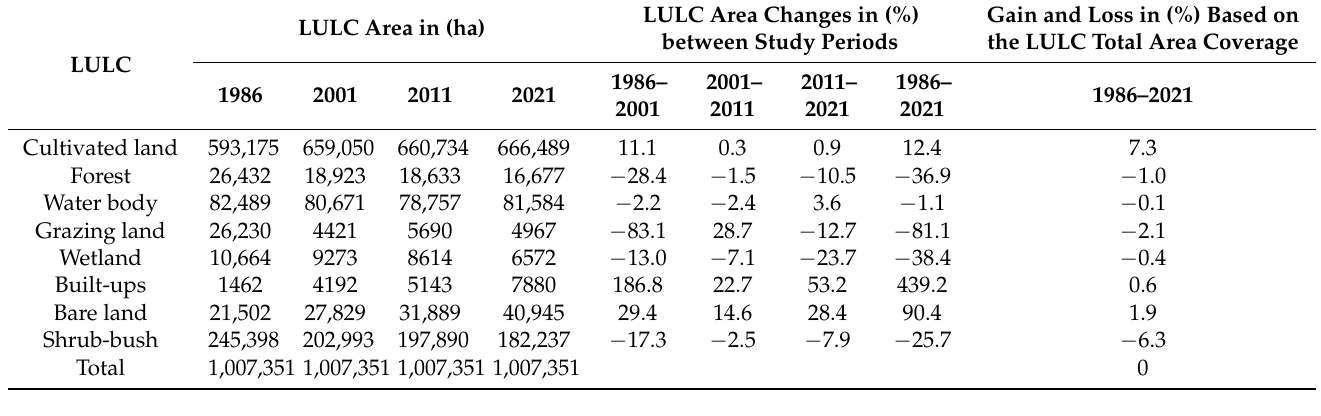
Table 3. LULC changes in the study periods (1986 to 2021).